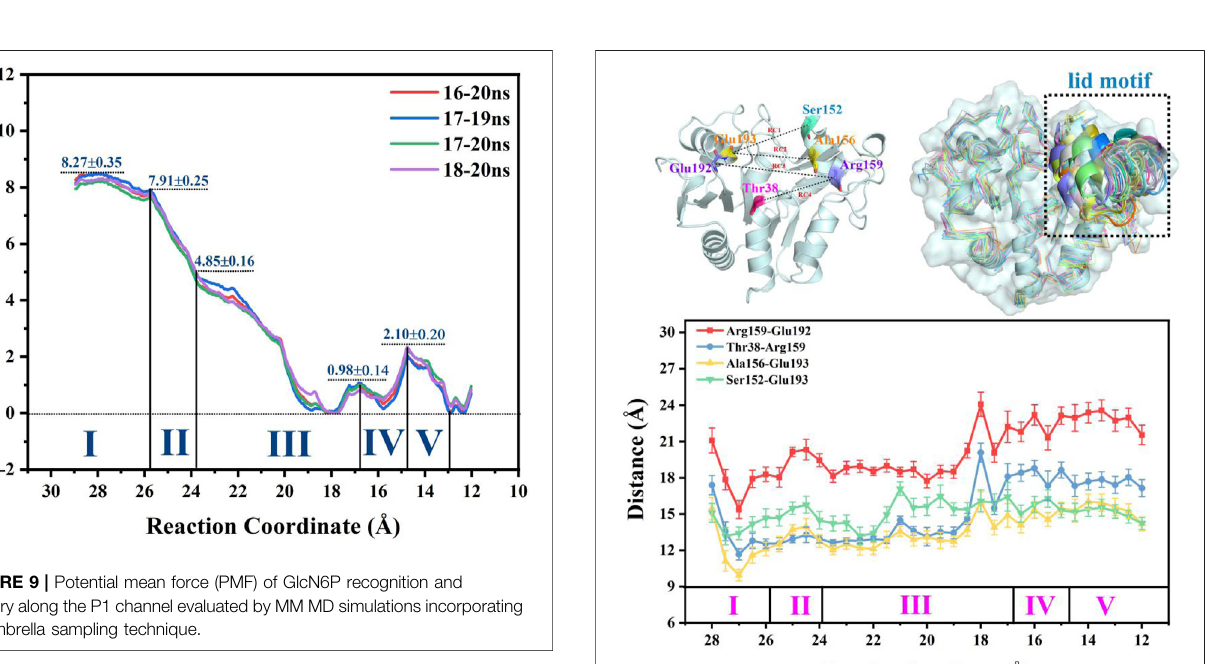
FIGURE 8 | Conformational changes to the substrate and key residues allowing substrate release along P1.